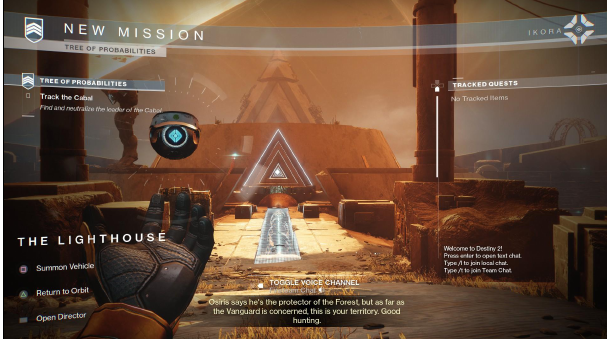
Figure 2. Current objectives shown through the game’s Heads-Up Display .